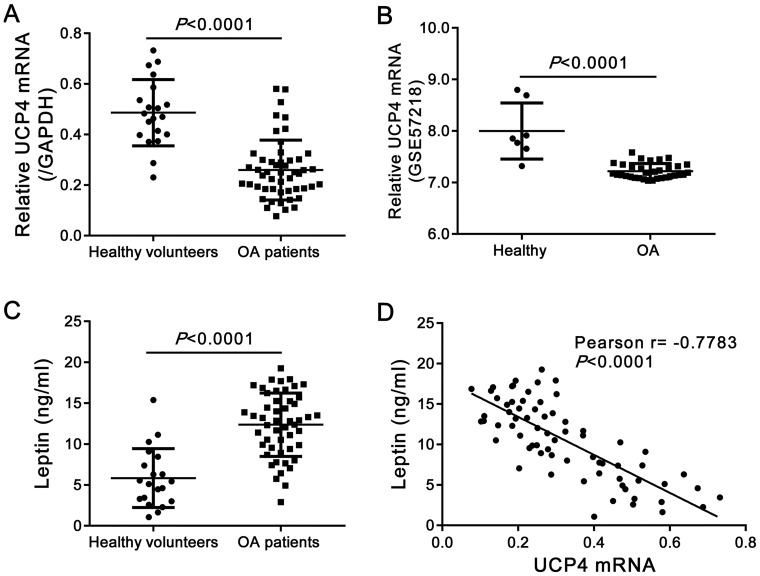
UCP4 mRNA was negatively correlated with leptin concentration.(A) UCP4 mRNA expression in cartilage tissues of osteoarthritis patients (n = 50) and health donors (n = 20) was evaluated by quantitative RT-PCR. (B) UCP4 expression analysis based on GSE57218 dataset. (C) Leptin concentrations in SF were measured by using radioimmunoassay kit. (D) Pearson correlation analysis between UCP4 mRNA and leptin SF concentration (P<0.0001).